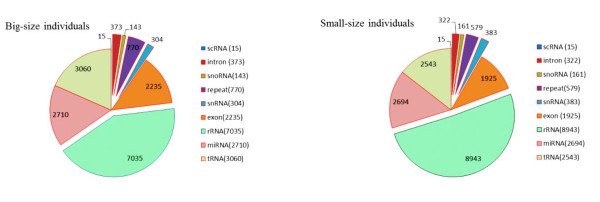
Annotation of small RNAs derived from Solexa sequencing of
M. amblycephala
small RNAs libraries.